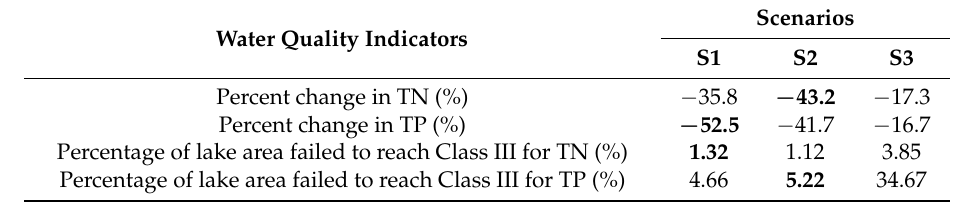
Table 6. Water quality indicators under different water diversion scenarios.